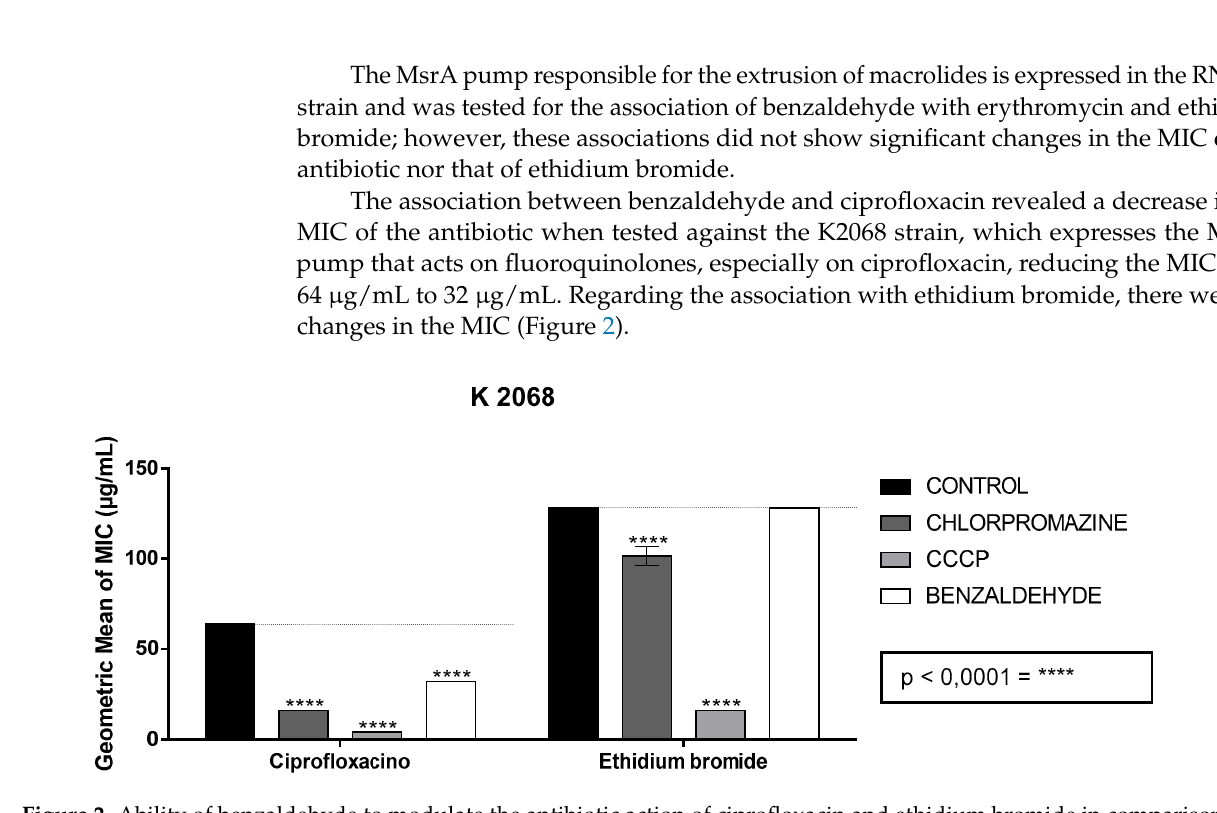
Figure 2. Ability of benzaldehyde to modulate the antibiotic action of ciprofloxacin and ethidium bromide in comparison with standard inhibitors (Strain K2068). Legend: carbonyl cyanide m-chlorophenylhydrazone (CCCP). The values represent the geometric mean ± S.E.M. (standard error of the mean). Two-way ANOVA was used, followed by Bonferroni’s post hoc. **** = p < 0.0001.